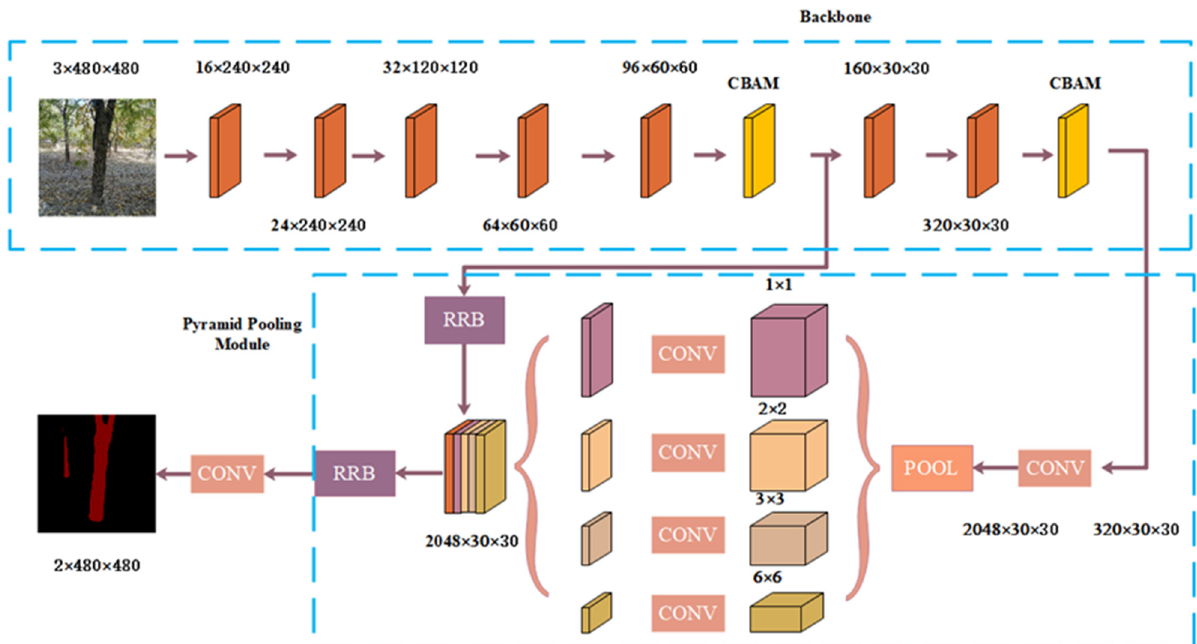
Figure 9. Structure diagram of jujube trunk segmentation model based on improved PSPNet. Where: CONV represents the convolution operation of the feature map. POOL represents the pooling operation of the feature map. RRB represents the refinement residual block.